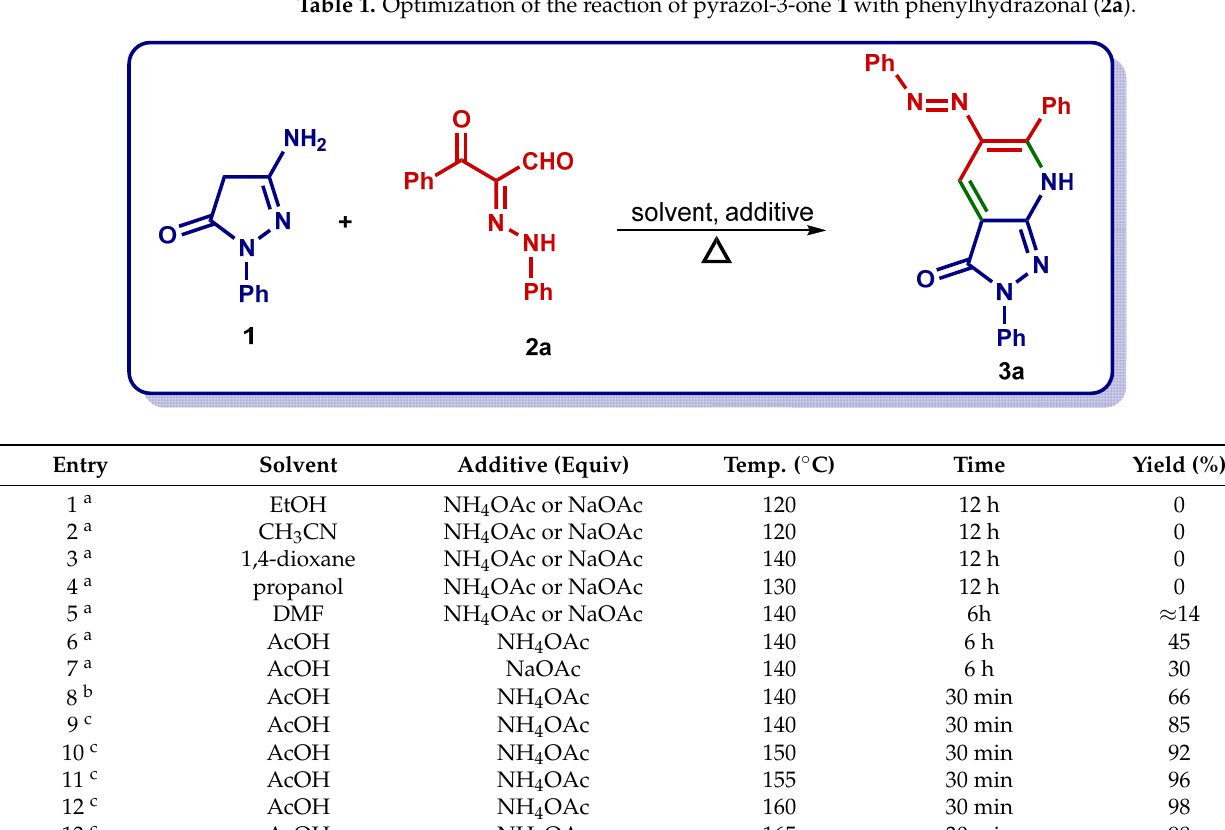
Table 1. Optimization of the reaction of pyrazol-3-one 1 with phenylhydrazonal ( 2a ).